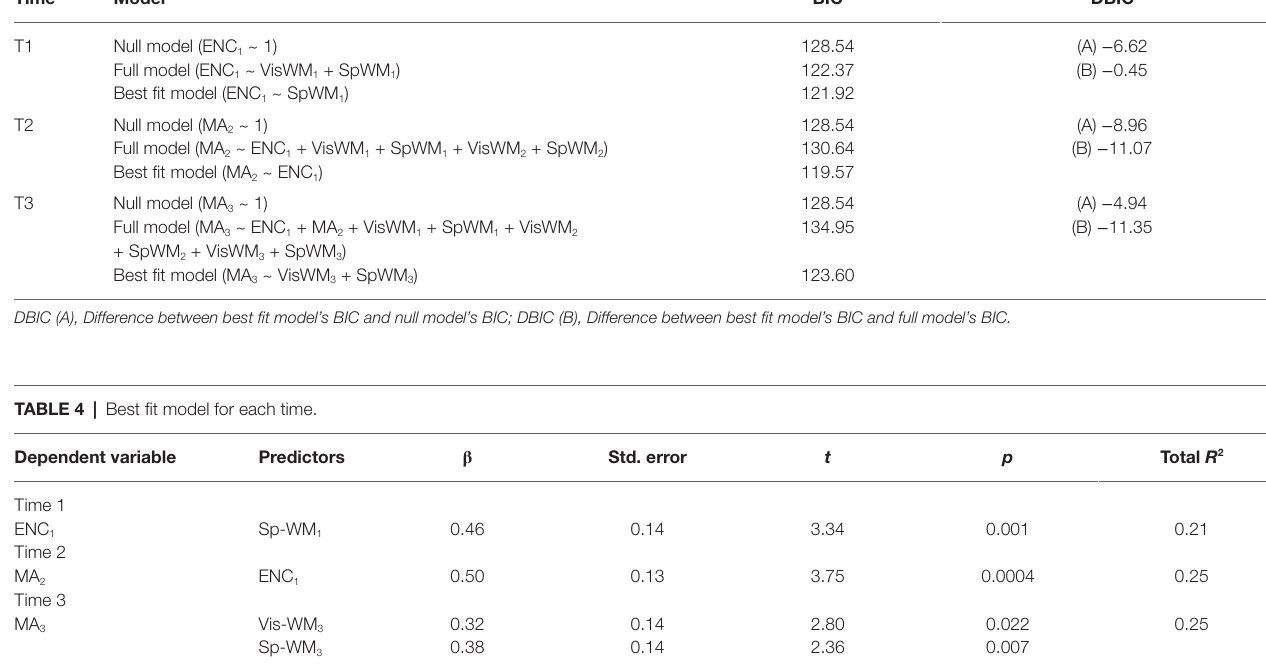
TABLE 3 | Models’ selection details: null model, full model, best fit model for each time and related BIC indexes and DBIC values. Time Model